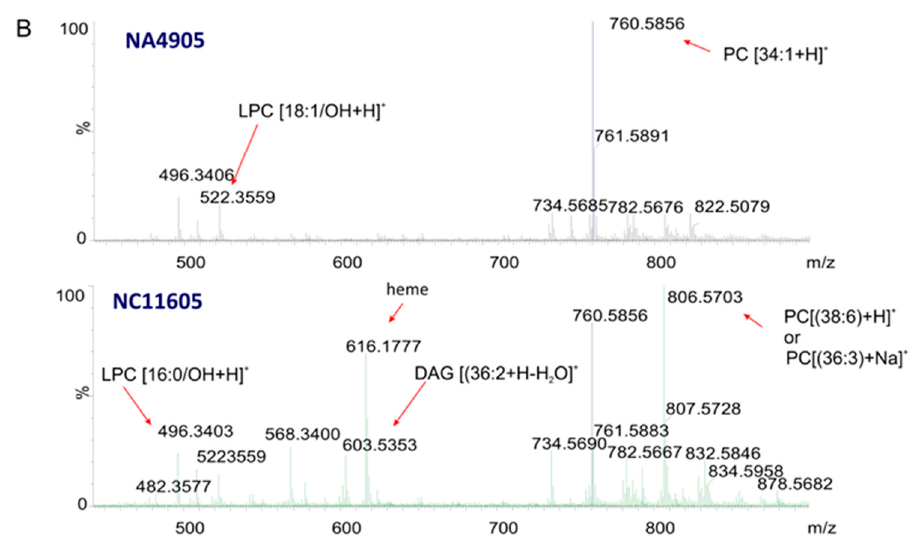
Figure 6. The MALDI mass spectra: ( A ) the average spectrum of ROI at m/z 603.5 in the kidney tissue slices of apparently healthy fish (control sample NA4905) and fish with mild infection (dermal lesions) (sample NA1905), ( B ) the average spectrum of ROI at m/z 806.5 in the tissue slices of healthy fish (control sample NA4905) and fish with systemic infection (septicemia) (sample NC11605). The red circle in the ( A ) represents the DAG (36:2) peak. The ion images of PC(36:3) at m/z 806.56 showed that the protonated PC(34:1) ion at m/z 760.58 was highly abundant in the tissue slices of trout kidney obtained from healthy fish (Figure 7). The average ROI spectrum of PC(36:3) at m/z 806.5 in the tissue sections of diseased fish was dominated by the protonated and sodiated phosphocholine species PC(34:1).